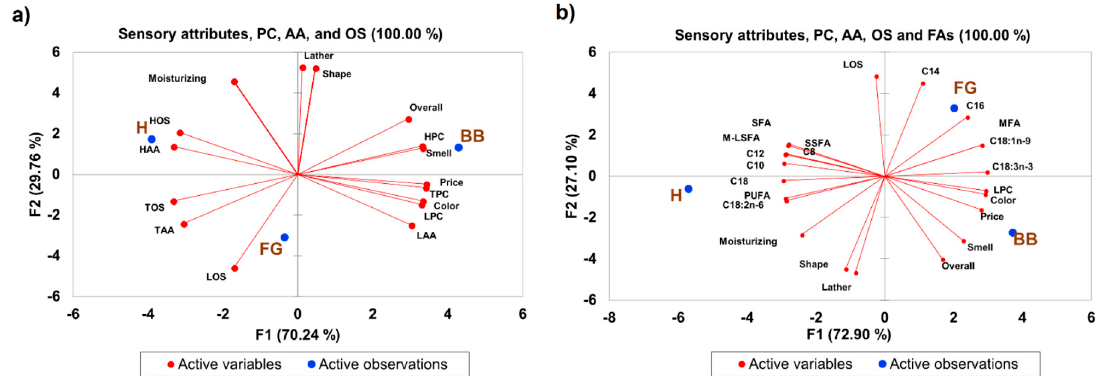
Figure 8. Principal component analysis showing the relationship between ( a )